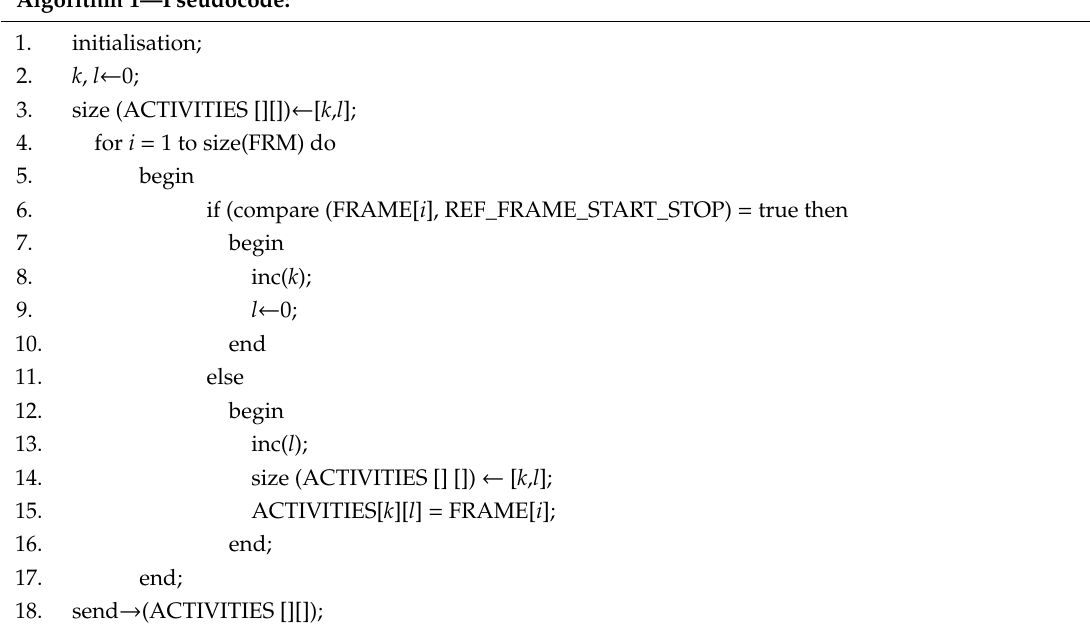
Algorithm 1: Algorithm for the Assignment of Reference Frames to Servicing